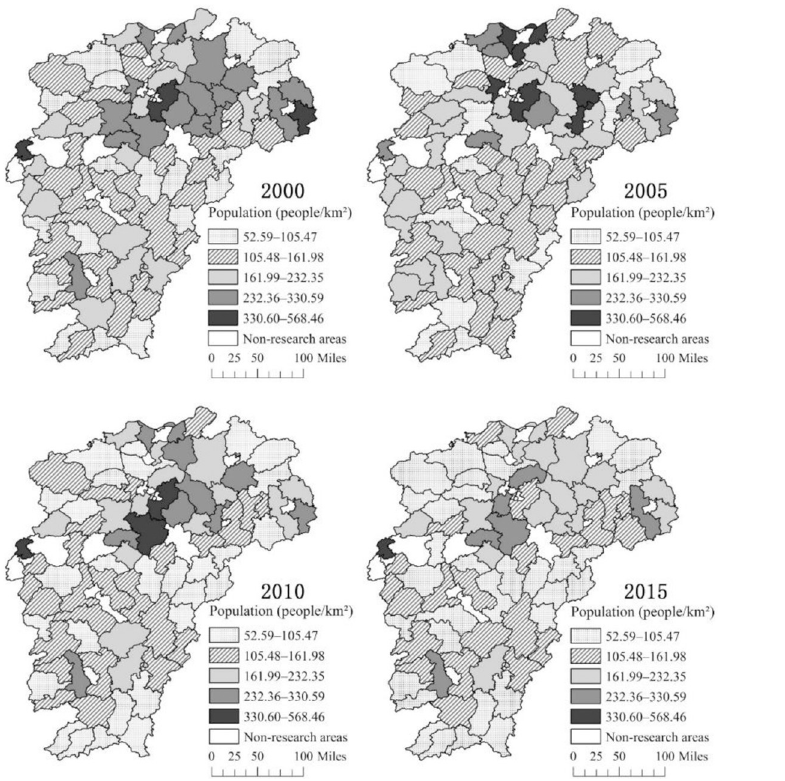
Fig 3. Spatial distribution of the rural population density in Jiangxi Province.